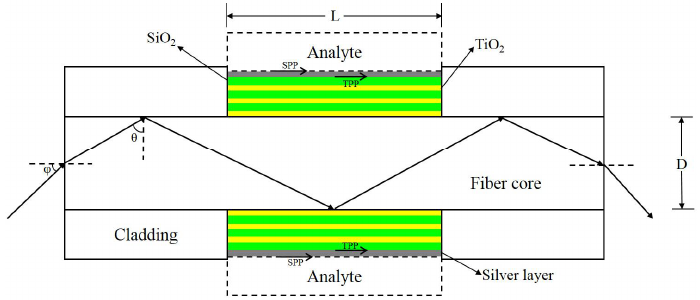
Figure 2. Sketch and ray model of solid-core fiber refractive index sensor based on 1 DPC/silver